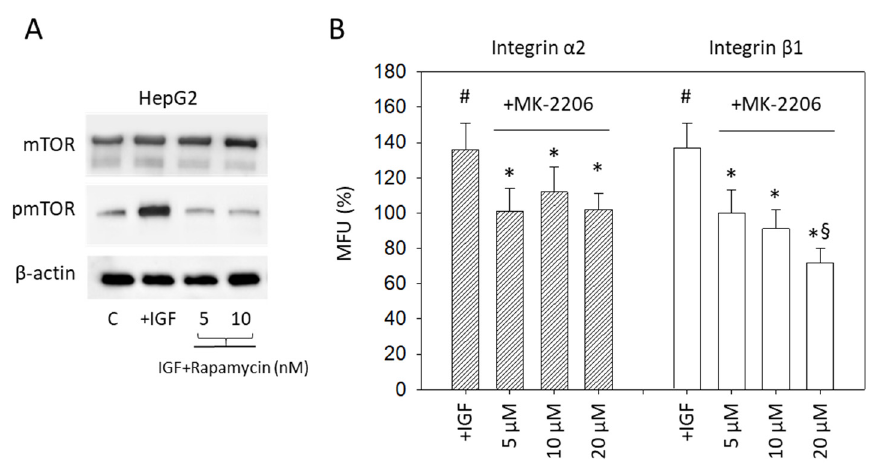
Figure 8. ( A ) mTOR and pmTOR protein expression. HepG2 cells were stimulated with IGF1 (IGF), remained untreated (C), or mTOR was blocked by the mTOR-inhibitor Rapamycin and then treated with IGF1. Protein analysis was accompanied by a β -actin loading control. One representative experiment of three is shown; ( B) Surface expression of the integrin subtypes α 2 and β 1 on HepG2 cells. Tumor cells were either exposed to IGF1 (+IGF) or stimulated with IGF1 under AKT blockade with MK-2206. Detection was completed by FACS analysis. Mean fluorescence values (MFU) are related to untreated controls set to 100%. # indicates significant upregulation, compared to cells not exposed to IGF. * indicates significant downregulation to IGF stimulated cells. § indicates significant downregulation to cells not exposed to IGF1 ( n = 3).